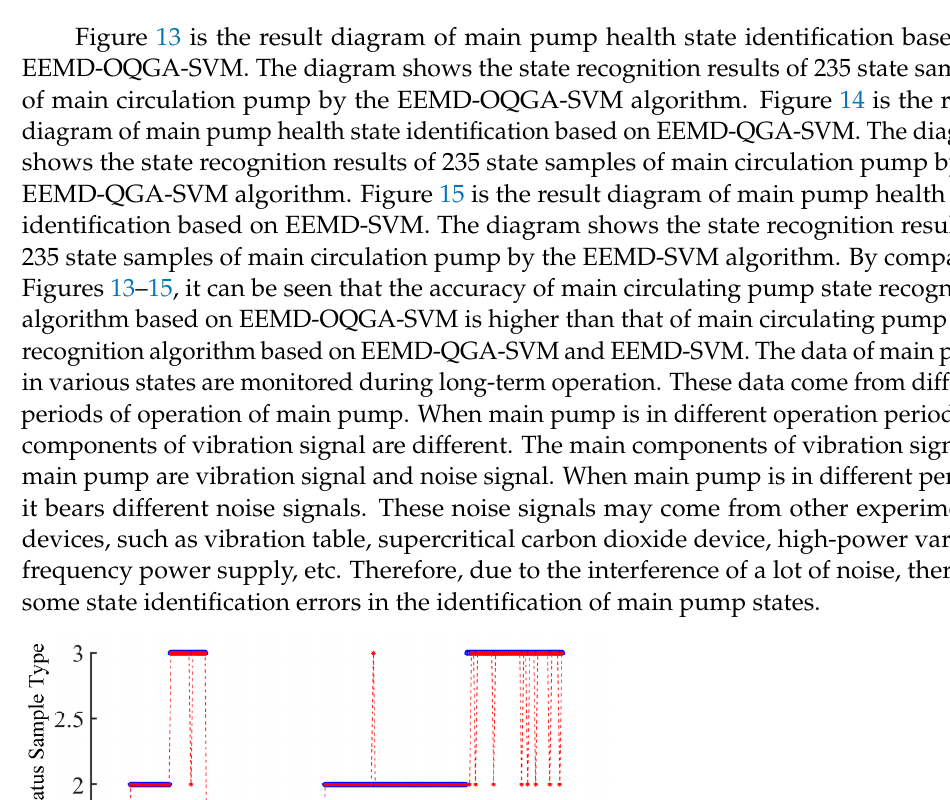
Figure 12. Iterative calculation process of main pump state identification based on EEMD-QGA- SVM algorithm. SVM algorithm.